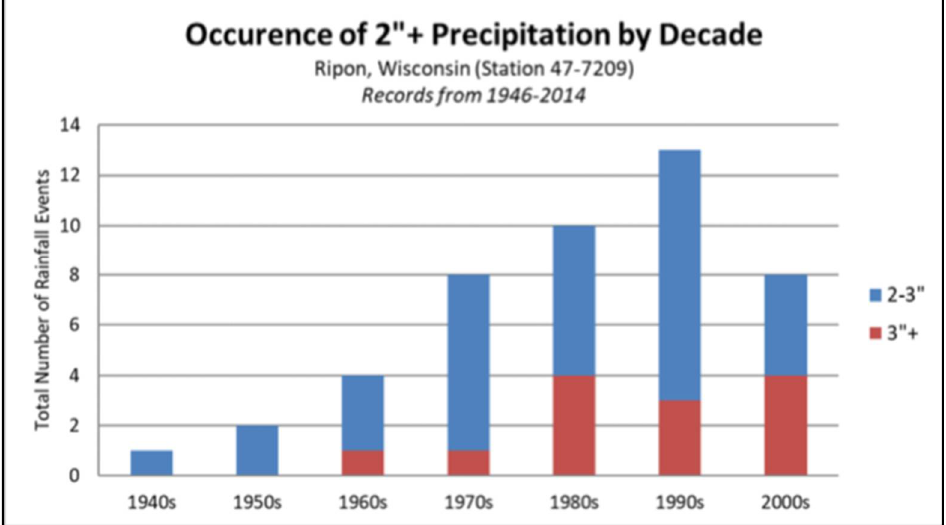
Figure 4. Magnitude of precipitation events by decade for Ripon, Wisconsin [10].